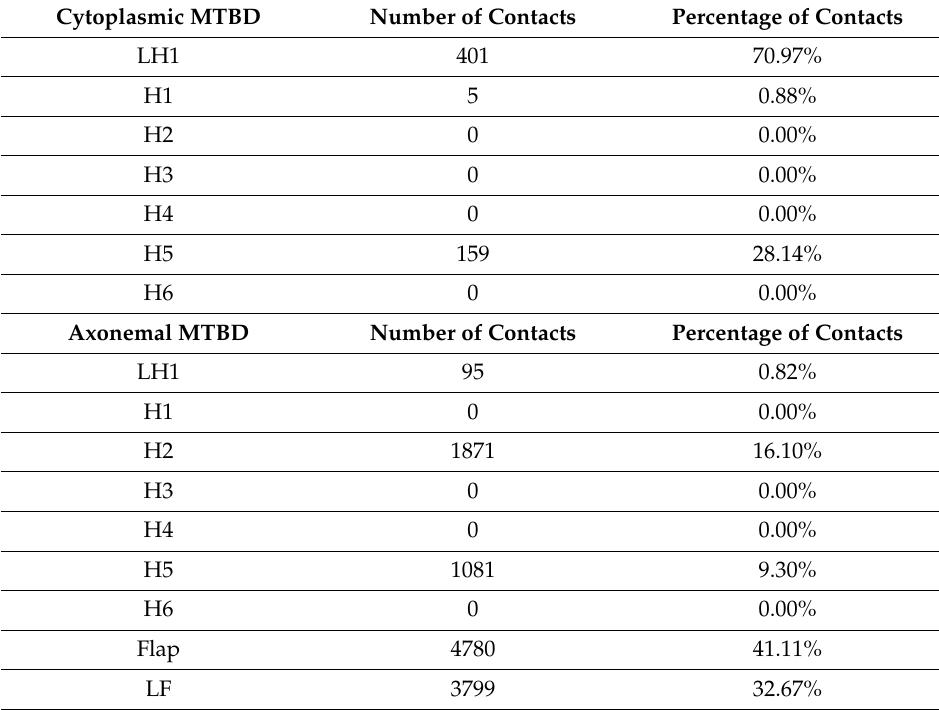
Table 1. The absolute number of contacts and their percentage for each helix of cytoplasmic and axonemal MTBDs at 0 Å, respectively (LF stands for “loop next to flap region”, and LH1 stands for “loop next to